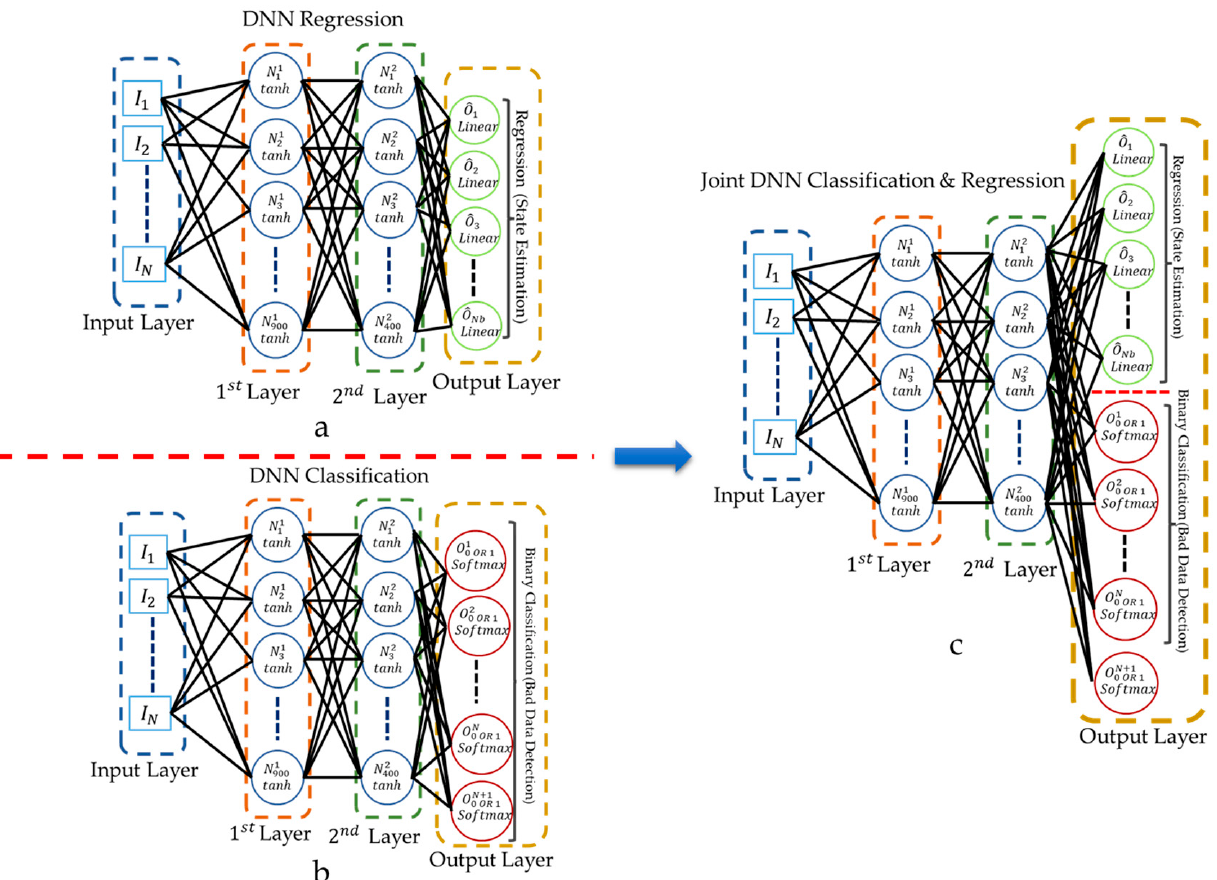
Figure 3. ( a ) A regression DNN architecture for DSSE calculation; ( b ) a binary classification DNN model for FDIA detection on measurements; ( c ) the proposed DNN model configuration to perform DSSE calculation and FDIAs on measurements simultaneously.